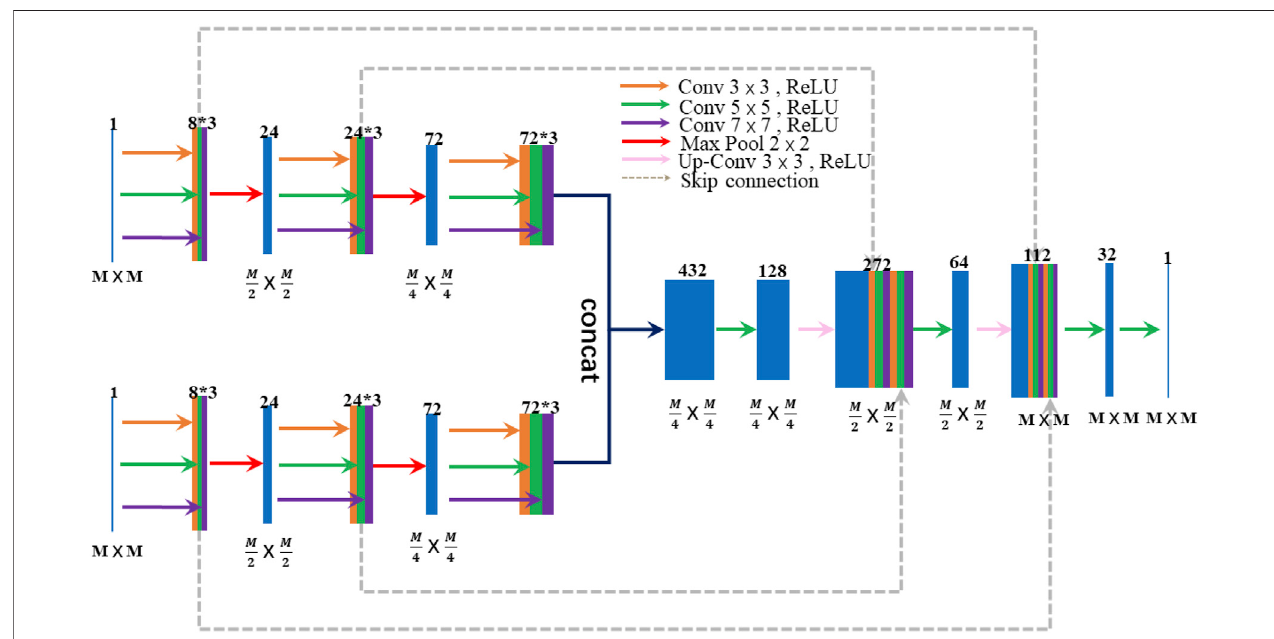
FIGURE 1 | The architecture of IY-Net. M represents the size of the feature map. The number at the top block represents the feature depth.